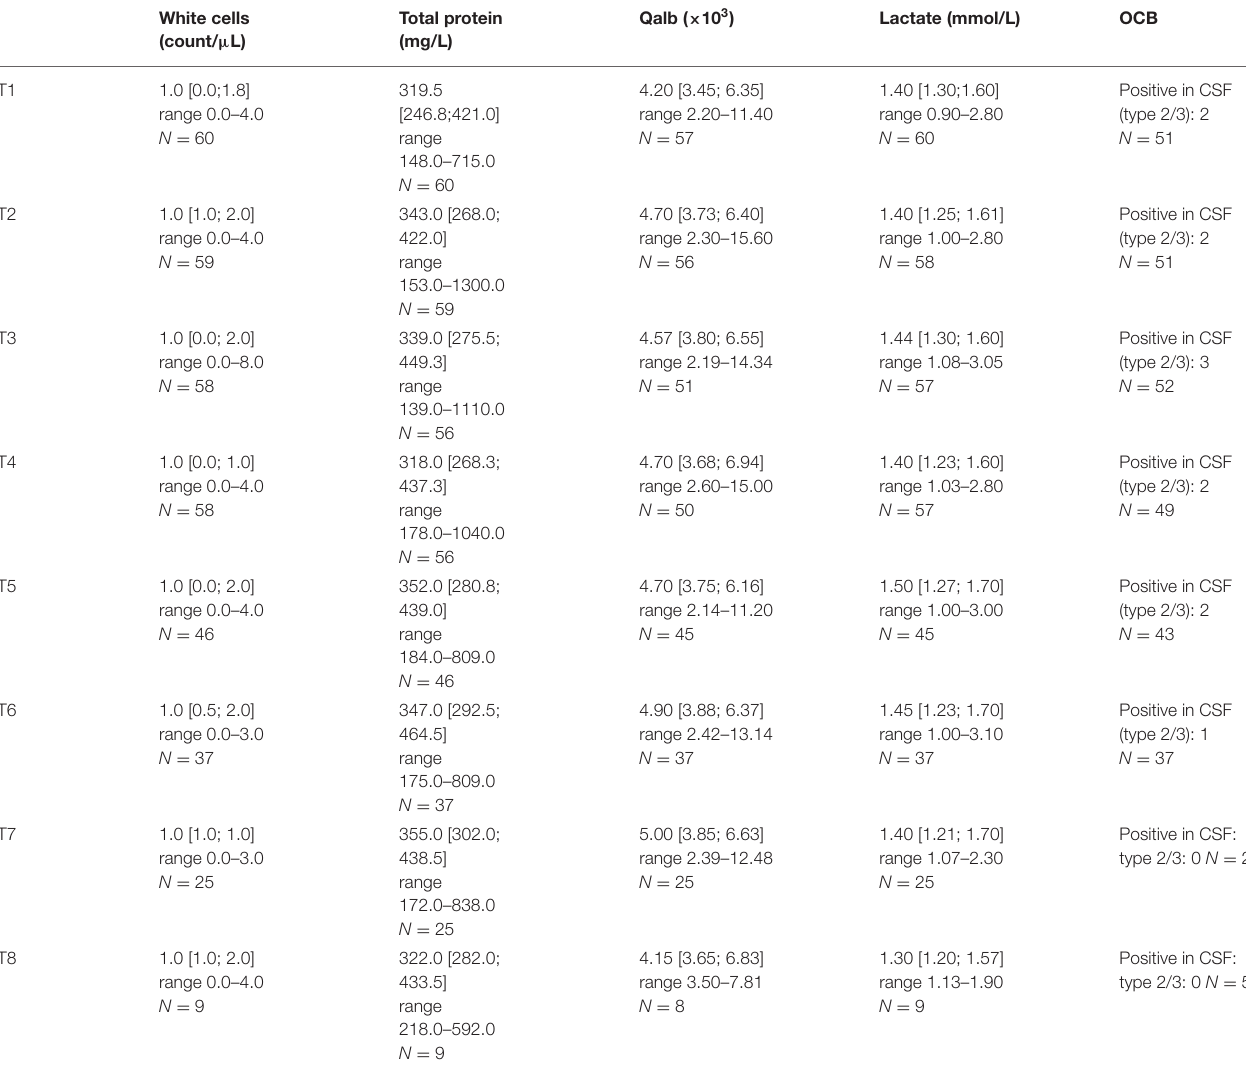
TABLE 2 | Illustration of routine CSF parameters in SMA patients undergoing treatment with nusinersen. White cells (count/ µ